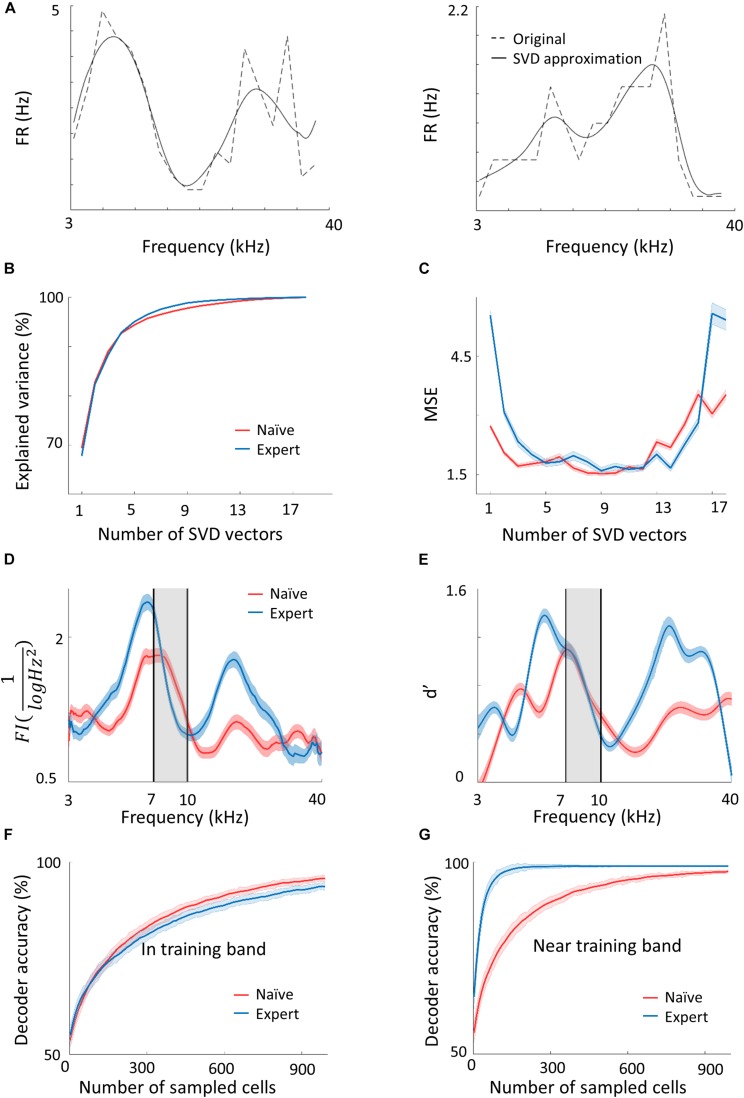
Plasticity in A1 does not improve the discrimination of the learned tones. (A) Two representative examples of tuning curves of neurons recorded in A1. Average spike rates and the SVD approximation of the particular curves are shown in dashed and solid lines respectively. Note that although the SVD approximation is smooth, it captures the irregular dynamics (i.e., non-Gaussian) of the tuning curves. (B,C) The explained variance and error as a measure of the number of SVD vectors used in the model. (D) Fisher Information calculated from the tuning curves of both populations along the frequency dimension. Note the increased FI for the expert neurons in the flanks of the training band but not within it (gray band). (E) Discriminability (d′) of SVM decoder along the range of frequencies. Pairwise comparison along the continuum is performed for frequencies 0.2198 octave apart. In accordance with d′, the decoder does not perform better in the training band (gray shade). (F,G) Classification performance of the decoder as a function of the number of neurons in the model. In the training band (F), the performance is similar for both naïve and expert mice. Outside the training band (0.4396 octave apart; (G) performance improved rapidly in the expert mice.